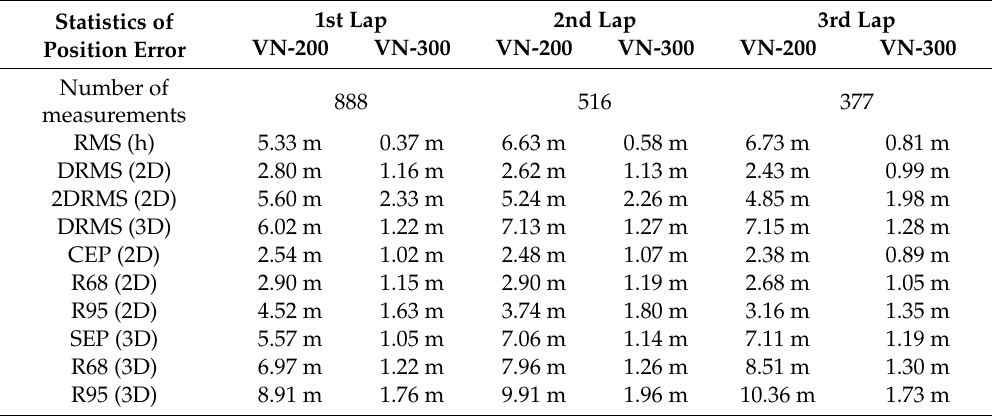
Table 11. Predictable positioning accuracy of VN-200 and VN-300 systems during Inertial Navigation System (INS) measurements in Gda´nsk in measurement